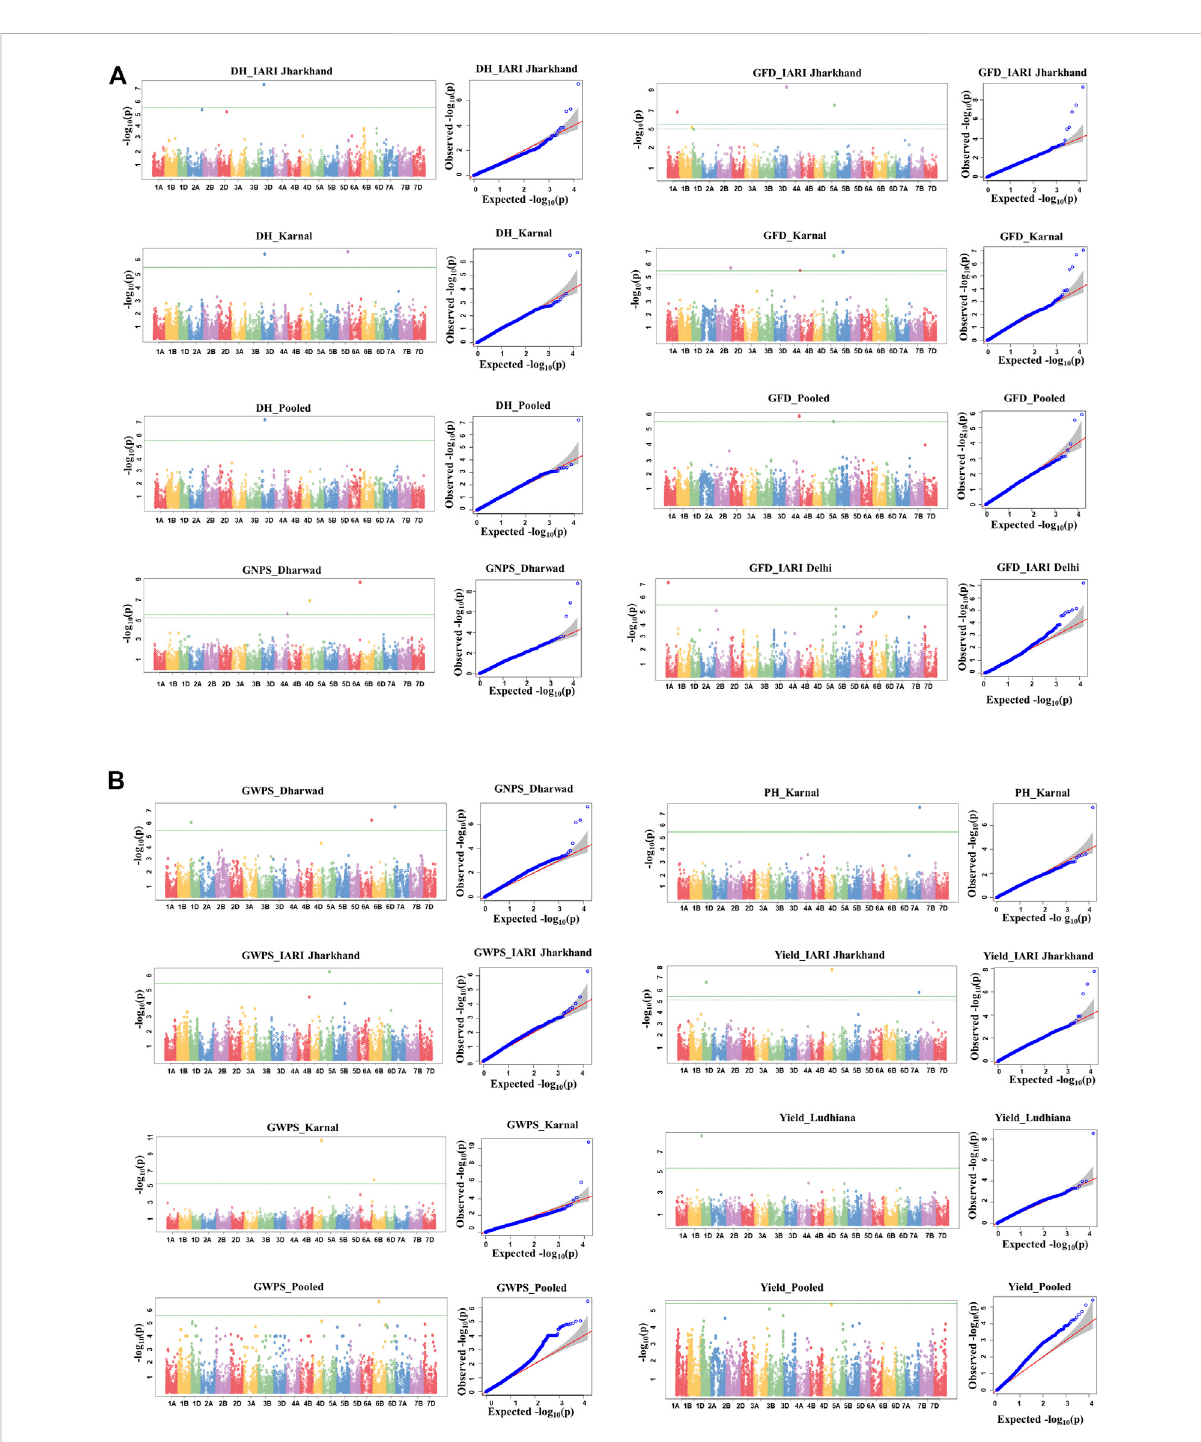
FIGURE 4 (A) Manhattan and respective-QQ plots for days to heading, grain number per spike, and grain fi lling duration in GWAS panel phenotyped at Dharwad, IARI Delhi, IARI Jharkhand, Karnal, and Ludhiana during 2020 – 2021. (B) Manhattan and respective-QQ plots for grain weight per spike, plant height, and yield in GWAS panel phenotyped at Dharwad, IARI Delhi, IARI Jharkhand, Karnal, and Ludhiana during 2020 –